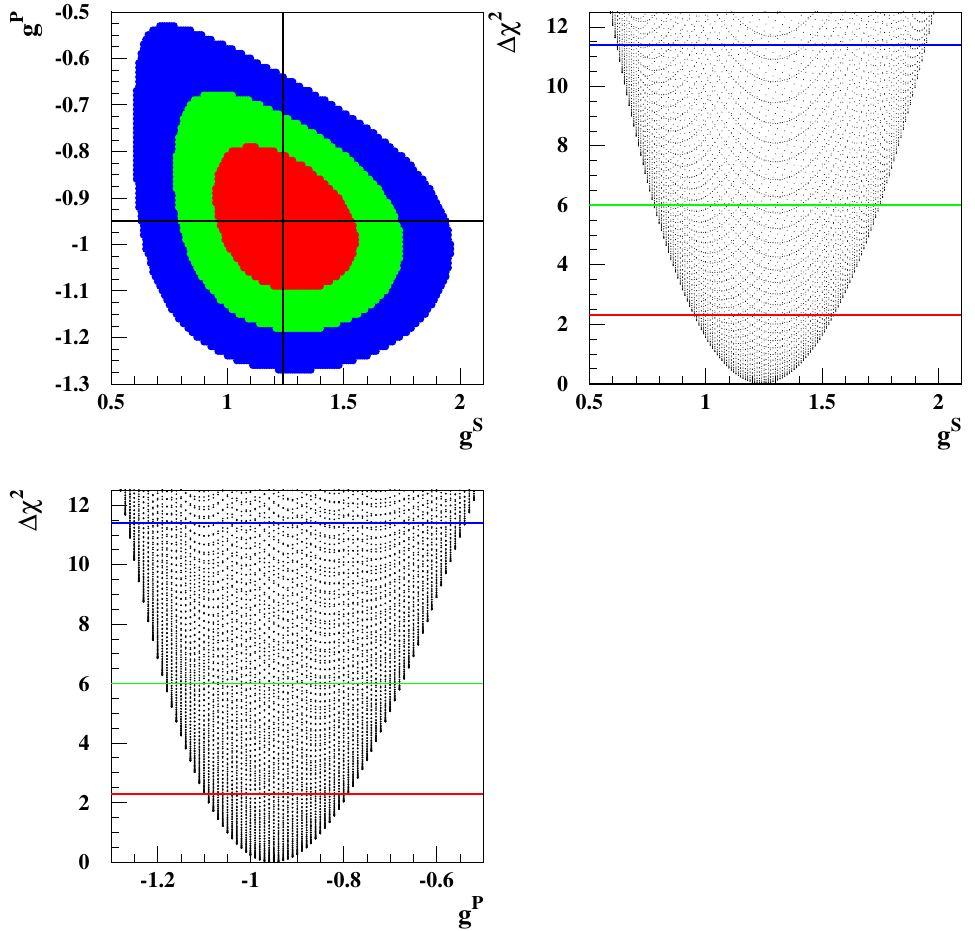
(cid:0) (cid:1) g S ; g P = (1 ; (cid:0) 1) with